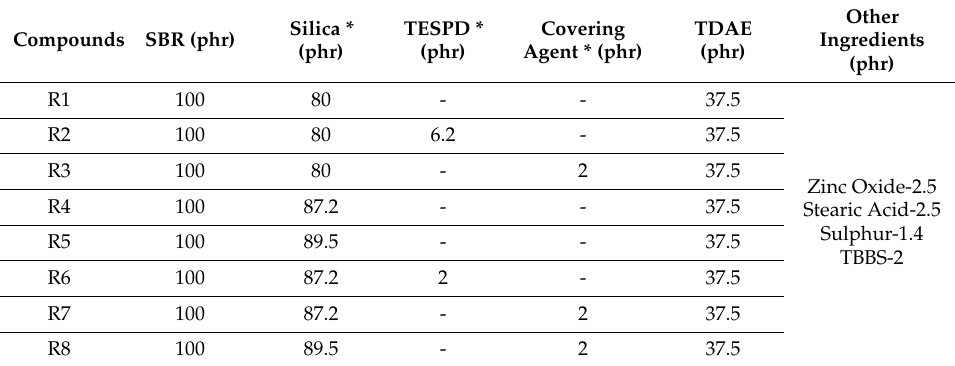
Table 1. Formulation of the rubber compounds in phr.